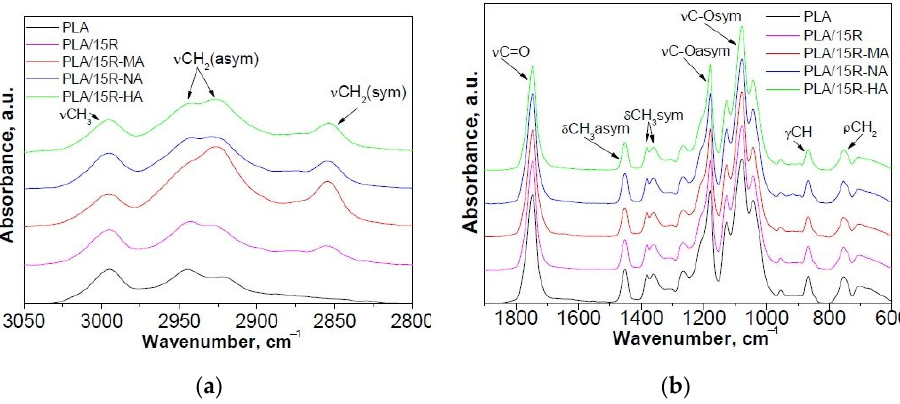
Figure 2. Normalized ATR-FTIR spectra of PLA/modified R samples compared with neat PLA and PLA/15R samples: ( a ) 2750–3050 cm − 1 and ( b ) 600–1900 cm − 1 spectral range. FTIR spectra of neat PLA displayed two bands at 2995 and 2943 cm − 1 (corresponding to the asymmetric stretching vibration of C–H from CH 3 and CH 2, respectively); a strong absorbance band at 1746 cm − 1 (attributed to the stretching vibrations of amorphous C=O groups); bands at 1452 cm − 1 and 1382 cm − 1 , 1359 cm − 1 characteristic for asymmetric and